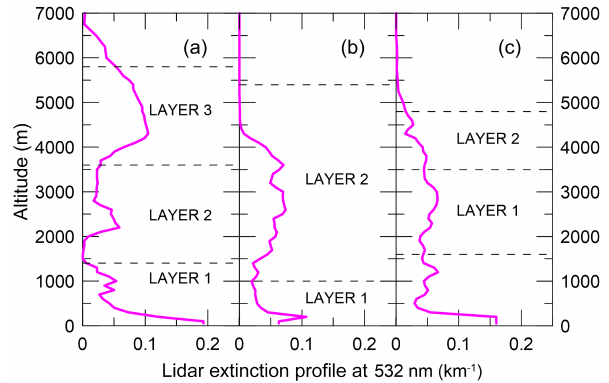
Figure 3. Lidar extinction profiles at 532nm averaged during the three ATR-42 descents for (a) 22 June (F35), (b) 28 June (F38), and (c) 3 July (F42). The aerosol layers identified by different opti- cal properties from the in situ airborne measurements are also evi- denced. Note that on 3 July the in situ profiles end at the bottom of layer